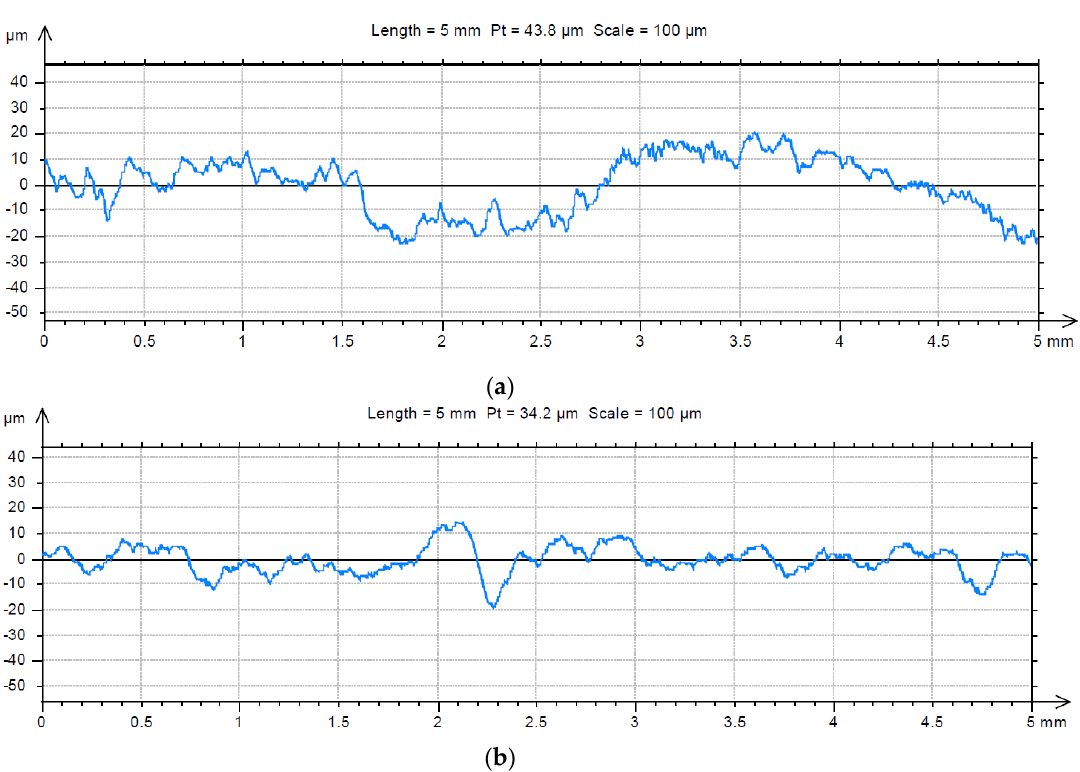
Figure 8. The surface of the reference material (chromium-nickel steel) ( a ) and material covered with biofilm ( b ).